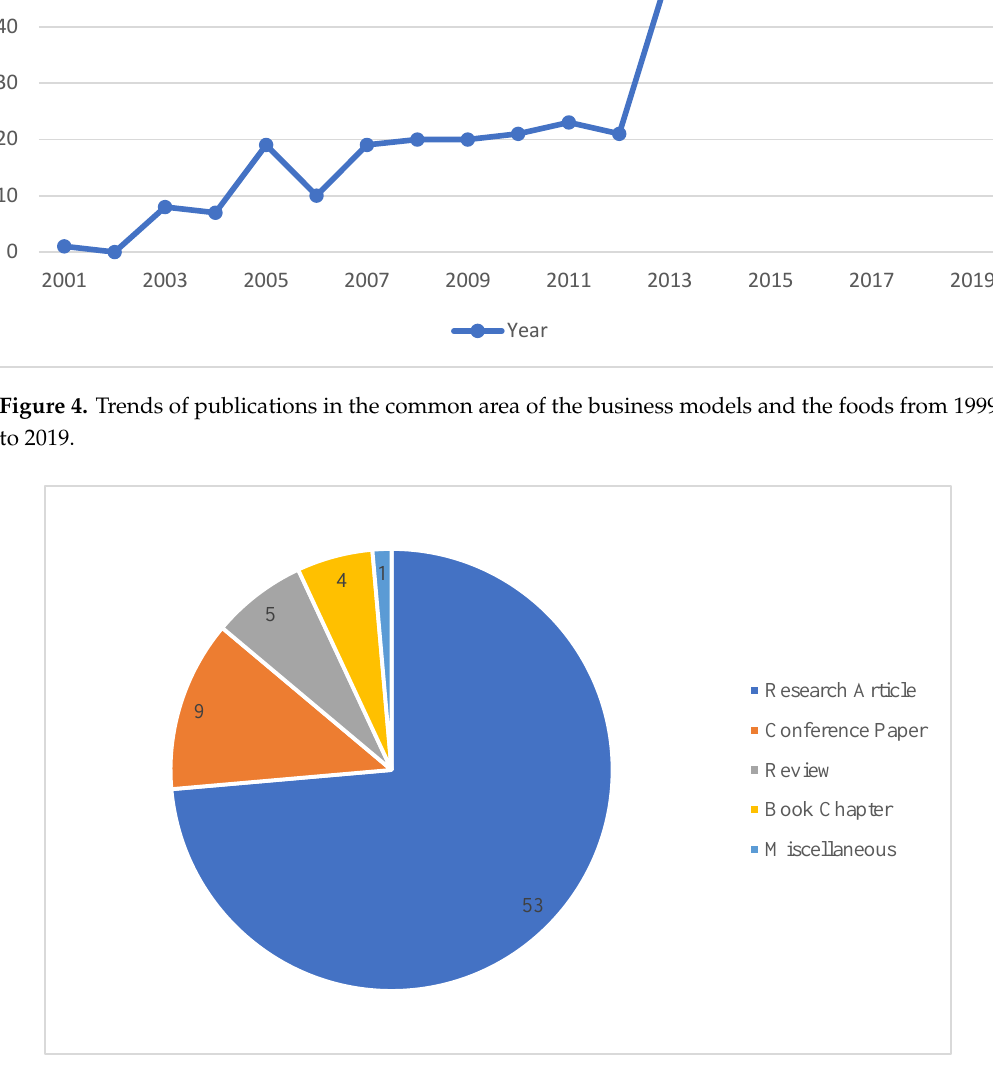
Figure 5. Types of documents considered in the current study.